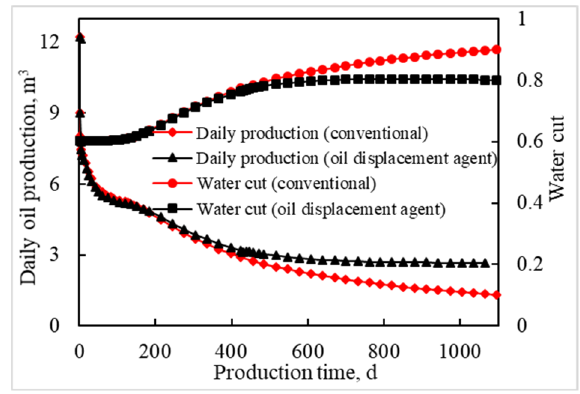
Figure 11. Influence of oil displacement agent on production efficiency.